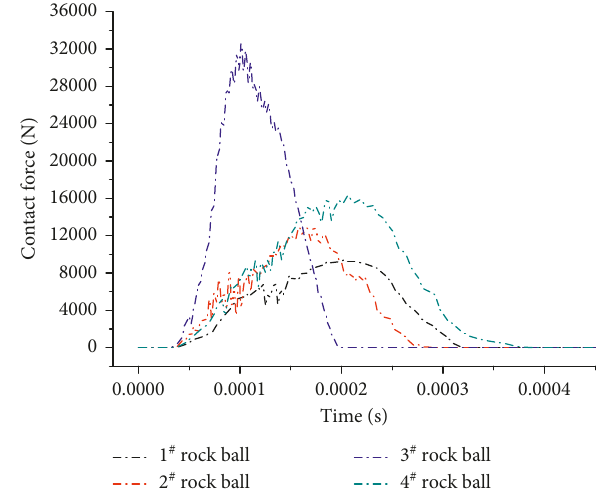
Figure 16: Simulation curves of contact force-time at 10m/s